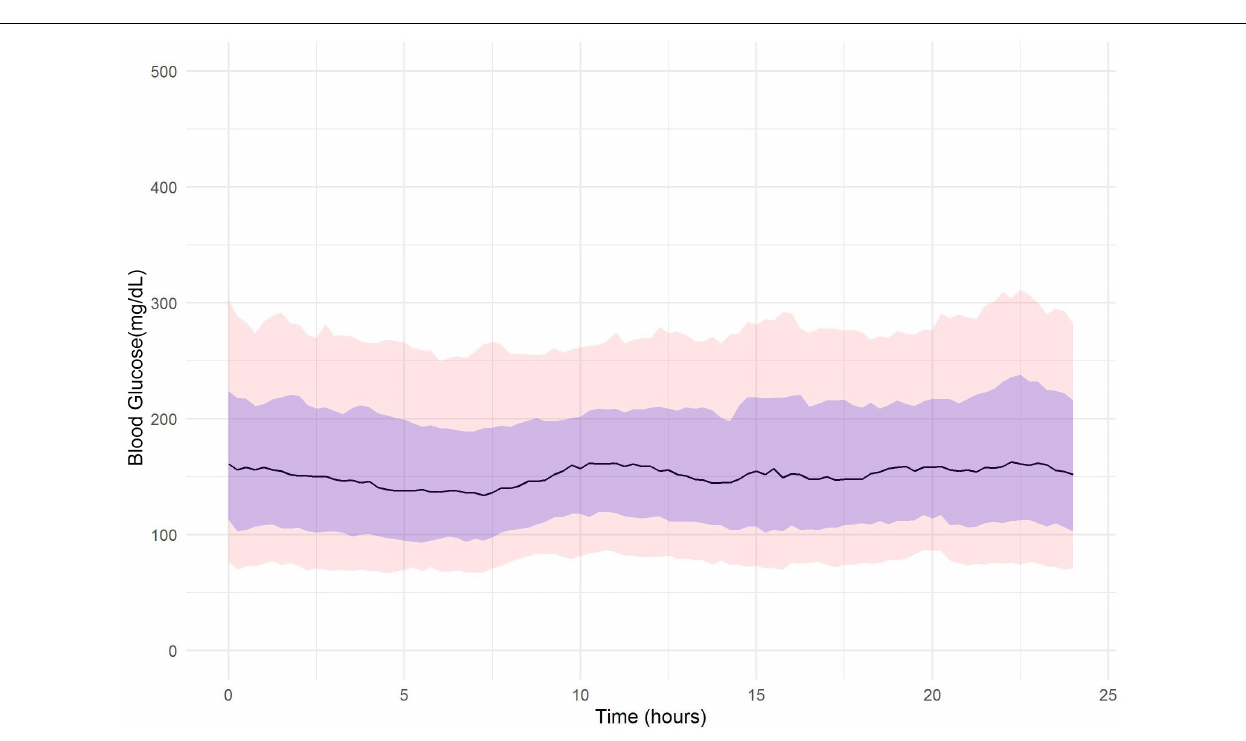
Frontiers in Nutrition |